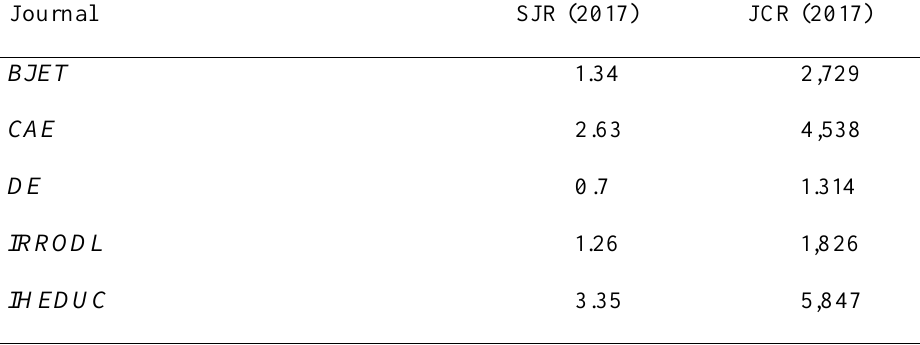
Characteristics of the Selected